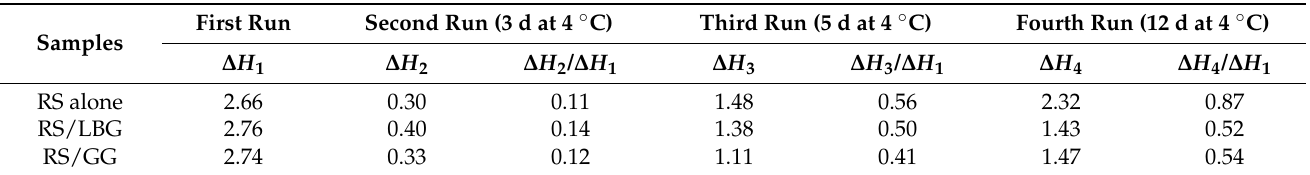
Table 5. The retrogradation thermodynamic parameters of RS alone, RS containing locust bean gum (RS/LBG), and RS containing guar gum (RS/GG)